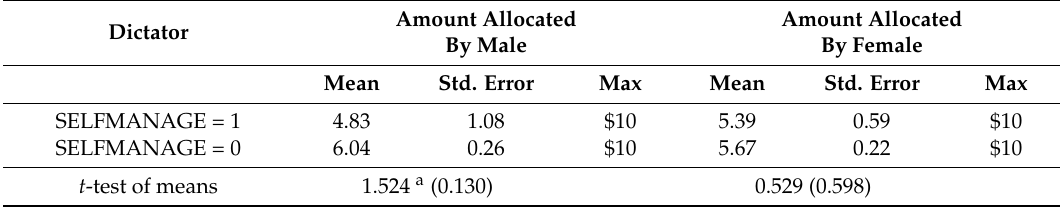
Table 8. Allocation of $10 based on SELFMANAGE by